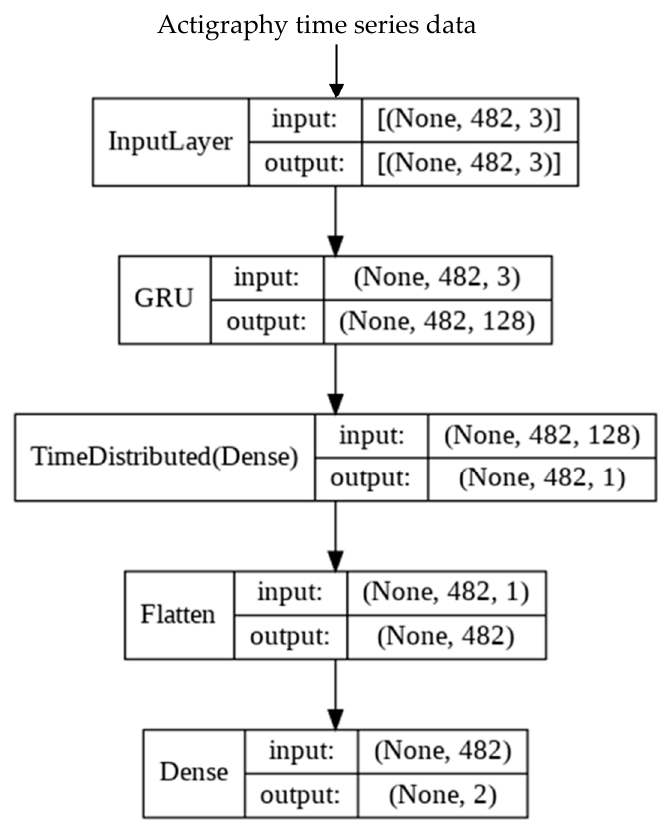
Figure A8. Configuration of GRU Model used for experiment with time series data.